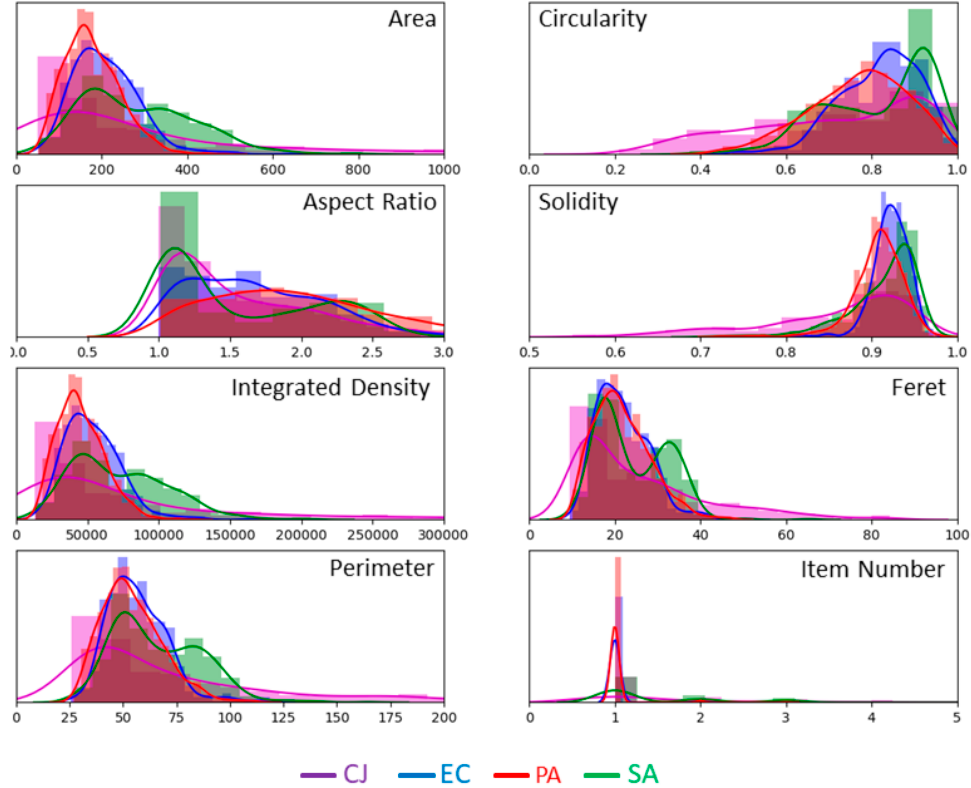
Figure 4. Histograms and fitted distribution of MPs computed on the images acquired in PBS. Plots are normalised, for each type of bacteria, by the number of objects in the dataset, i.e., 511 for C. jeikeium , 519 for E. coli , 917 for P. aeruginosa and 419 for S. aureus.